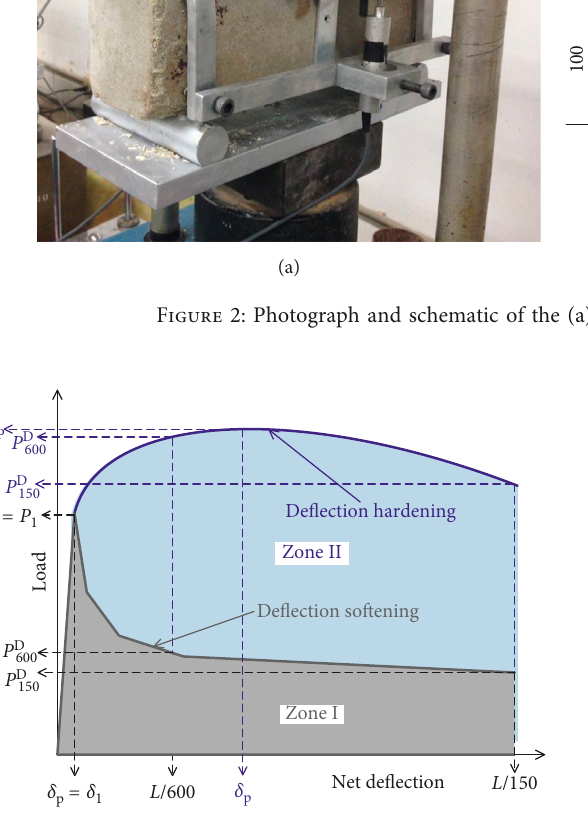
Figure 3: Definition of the load-net deflection curve from the flexural performance test (ASTM C1609) and the equivalent flexural strength